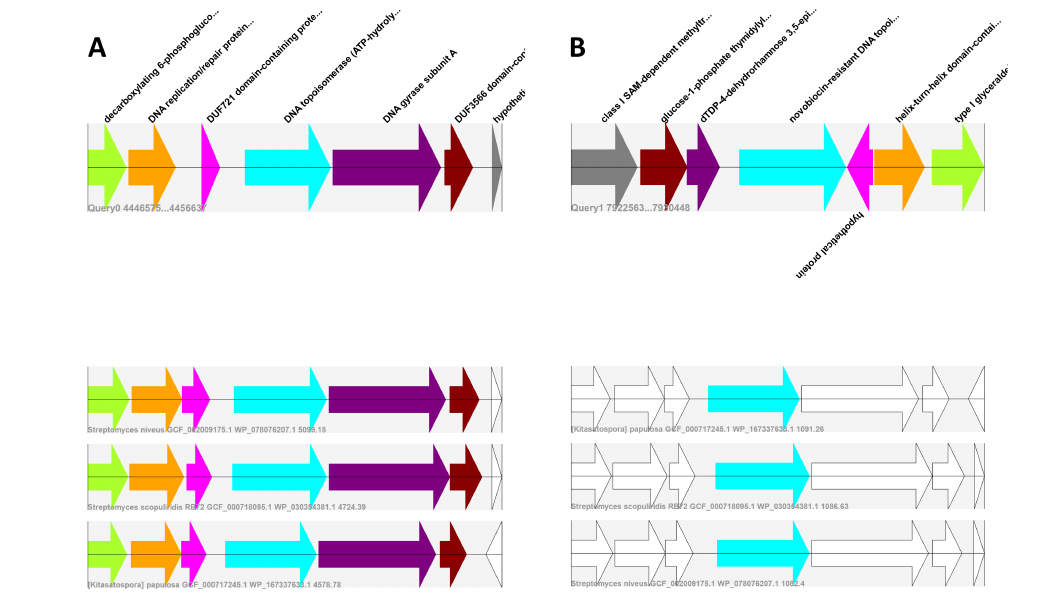
Figure 1. Exemplary result of SYN-view. The figure shows two alignments of NGIs throughout the closest relatives of Streptomyces nivues NCIMB 11891 (Table 1). Note that for a clear comparison, only two NGI alignments are shown, while three were found (Supplementary Data). ( A ) NGI of DNA topoisomerase which is regularly observed in close relatives with the structure of the NGI is well conserved. ( B ) The NGI of the duplicated, resistant gyrB is unique to the antibiotic producing strain and can easily be